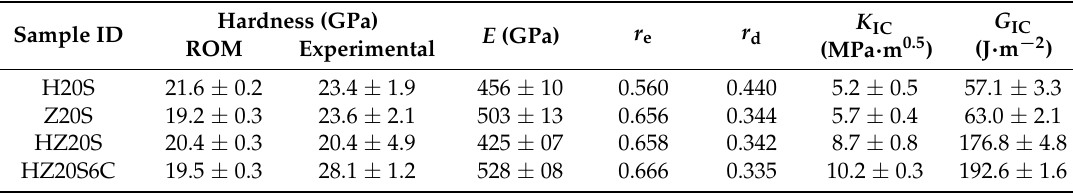
Figure 6. Load vs. displacement curves for HfB 2 -ZrB 2 -SiC-CNT composites observed during instrumented indentation. Table 2. Mechanical properties of HfB 2 -ZrB 2 -SiC-CNT composites. Here, ROM = rule of mixture, E = elastic modulus, r e = elastic recovery, r d = resistance to deformation, K IC = fracture toughness and G IC = critical energy release rate.